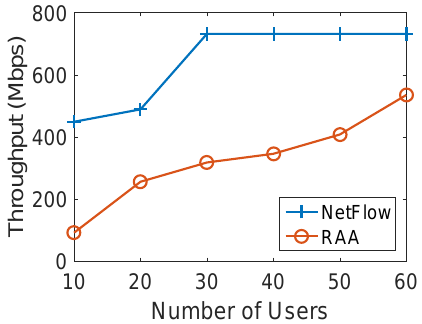
Figure 12. Throughput with non-uniform distribution.